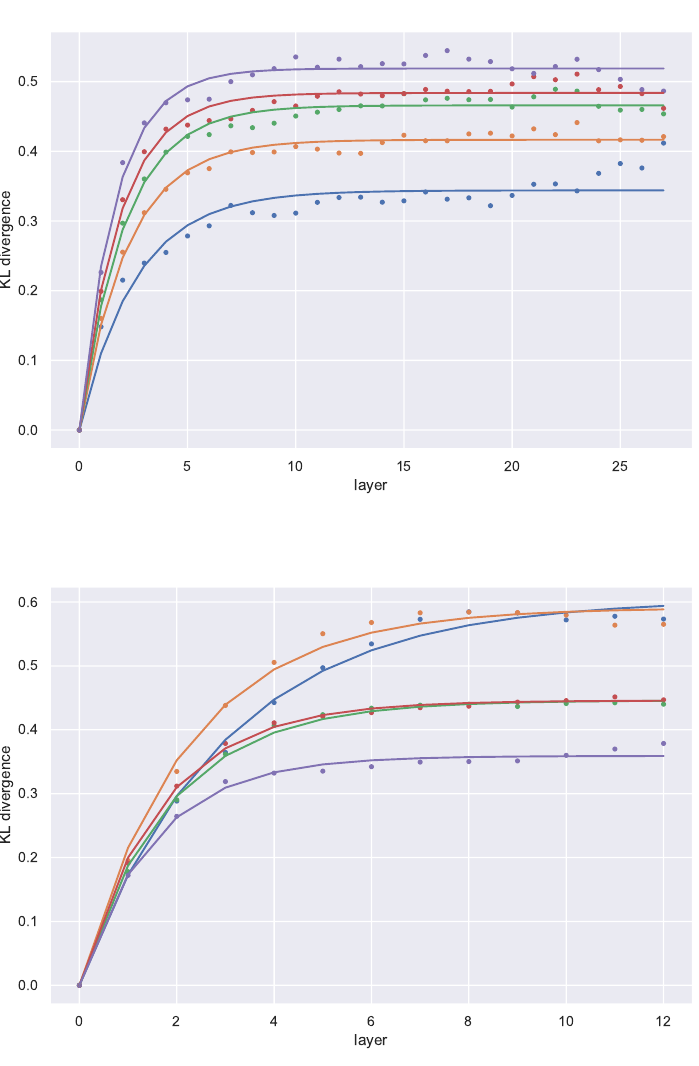
Figure 8: Fit of the after-training MNIST (top) and CIFAR-10 (bottom) data in fig. 7 to (90), with the parameter values shown in table 1. We expect one could obtain smoother results by using additional training data, or simply averaging over runs.